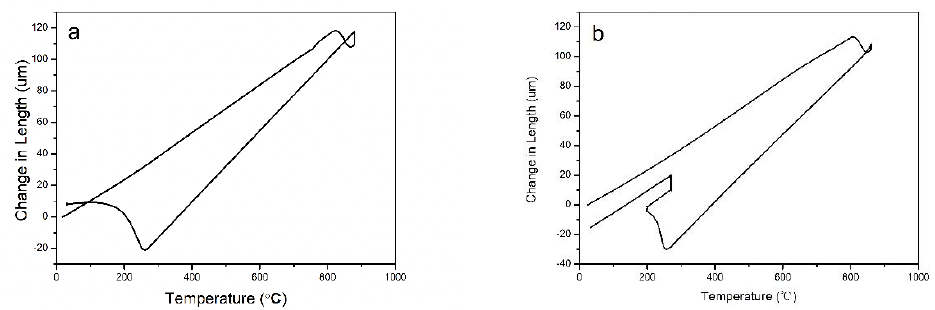
Figure 2. ( a ) Change in length during continuous cooling. ( b ) Change in length during the quenching and partitioning (Q & P) process.